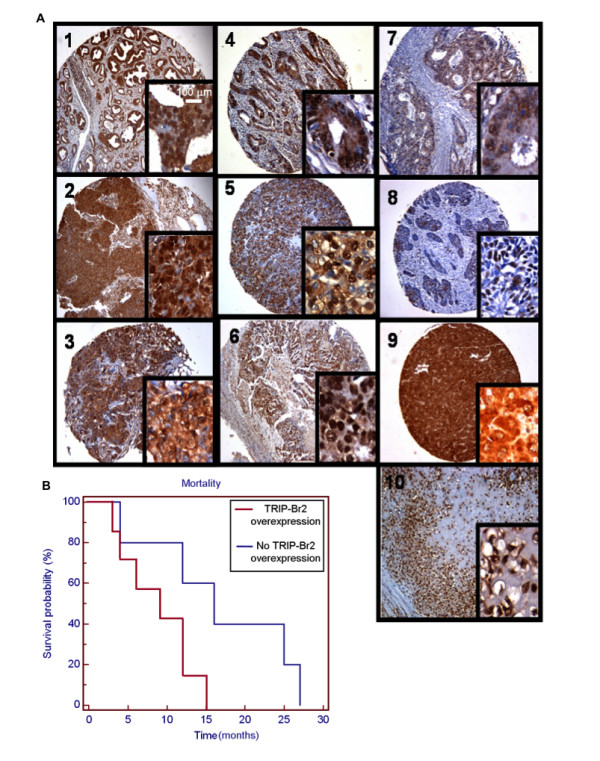
TRIP-Br2 is overexpressed in multiple human solid tumors and associated with poor prognosis in hepatocellular carcinoma (HCC). (A) Multiple human tumor tissue arrays were immunostained with rabbit anti-TRIP-Br2 polyclonal antibodies. 1: Prostate carcinoma; 2: Squamous cell lung carcinoma; 3: Breast carcinoma; 4: Gastrointestinal stromal tumors, GIST; 5: Renal cell carcinoma; 6: Ovarian carcinoma; 7: Colon carcinoma; 8: Basal cell carcinoma; 9: Hepatocellular carcinoma; 10: Osteosarcoma. The small insert represents 400× magnification of the tissue in each window (shown at 100× magnification). A scale is included in the small insert of window #1 (for all 400× magnified tissue specimens). Immunopositive staining for hTRIP-Br2 is represented by the brown color against the hematoxylin (blue) counterstain. Data was obtained from three independent experiments that were performed in triplicates. (B) TRIP-Br2 overexpression is associated with poor survival of HCC patients (n = 12). The mean survival of patients with TRIP-Br2 overexpression (9 months) was significantly lower than that of HCC patients without TRIP-Br2 overexpression (16 months). The p-value of this survival analysis was determined to be 0.0452 using the Kaplan Meier log rank test.